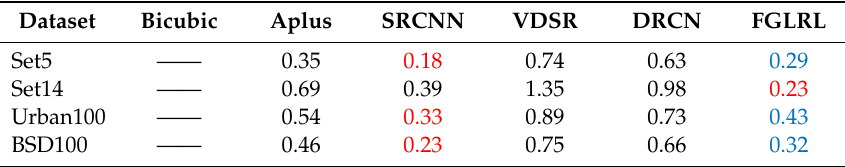
Table 2. Comparison of average running time of various algorithms.